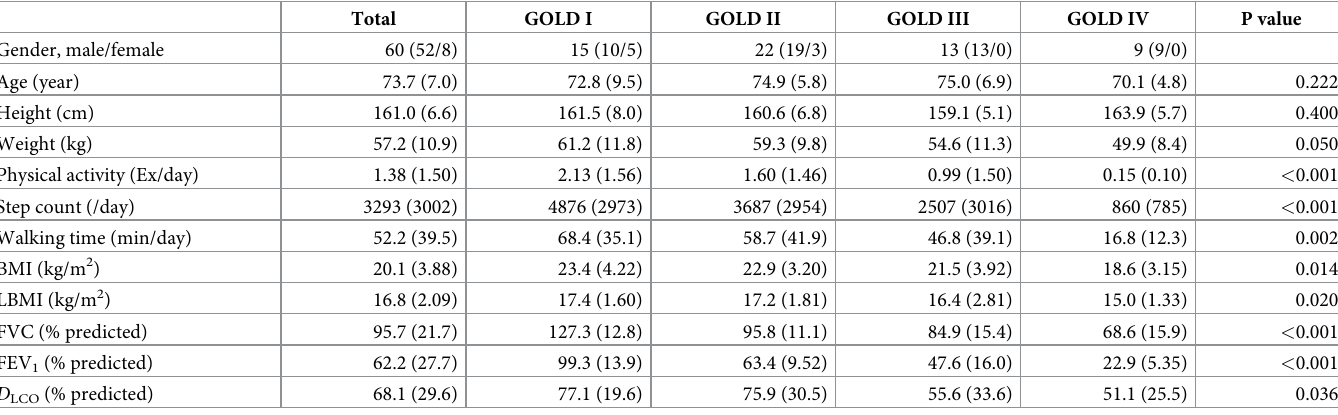
Table 1. Mean values of demographic characteristics and pulmonary function by GOLD